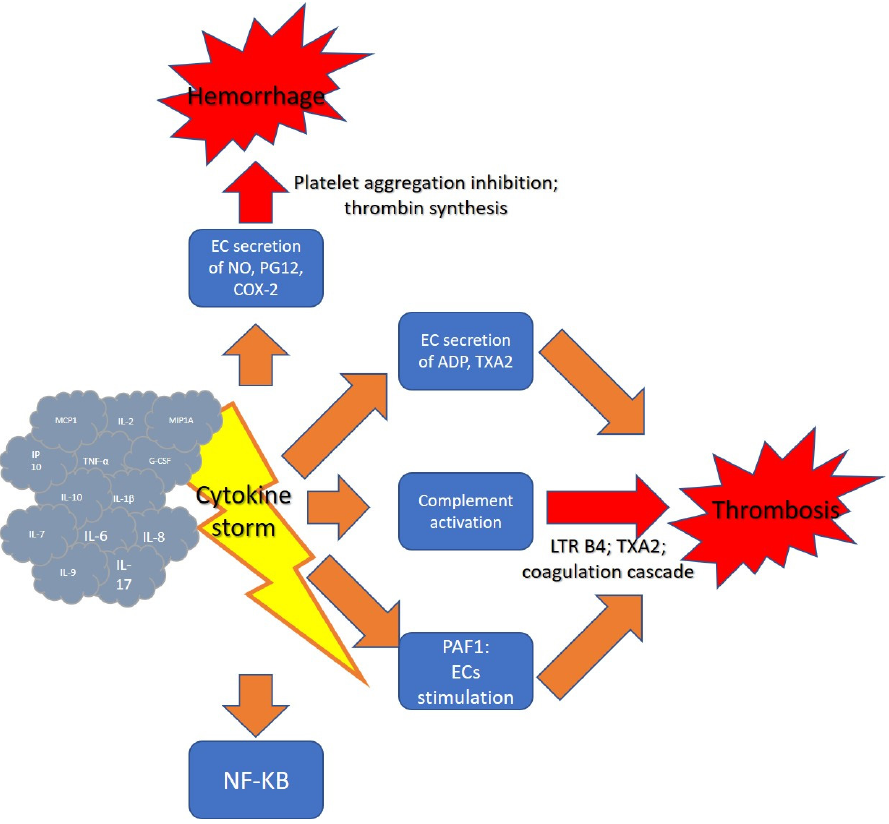
Figure 1. Cytokine storm and hemostasis.